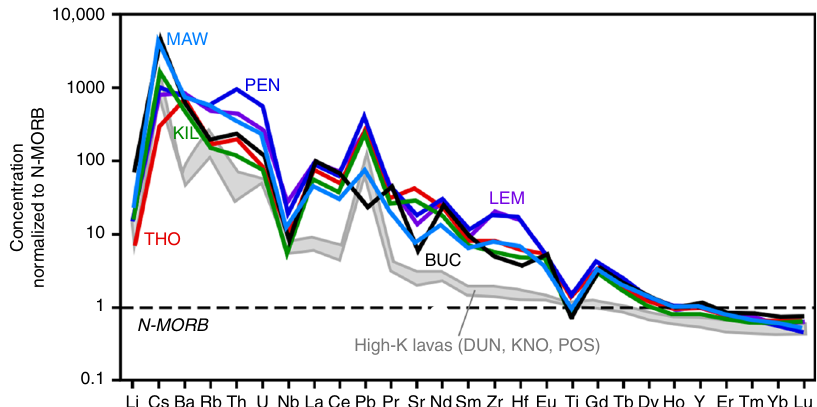
Fig. 2 Extended trace element spidergrams for selected samples. Shown are six of the least altered lamprophyres, and three potassic calc-alkaline lavas, with concentrations normalized to normal mid-ocean ridge basalt (N-MORB). Diagrams show the enrichment in incompatible elements and the steep slope of the heavy rare earth elements